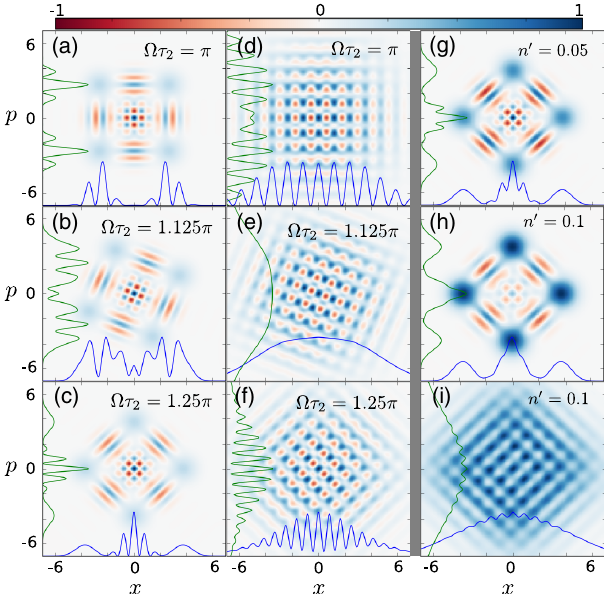
FIG. 5. Wigner distributions of the resonator ’ s state at different values of τ 2 . (a) – (c) Maximum interference from an initial pure state with unitary evolution. (d) – (f) Loss of interference due to initial thermal phonon occupation ¯ n ¼ 5 (with unitary evolution). (g) – (i) Loss of interference with nonunitary evolution equivalent to adding 0.05 (g) or 0.1 (h,i) thermal phonons. The initial state for panels (g) and (h) is the vacuum state, and the initial state of panel (i) is a thermal state with ¯ n ¼ 5 phonons. Blue and green traces show the position and momentum marginals, respectively, normalized to the same maximum. Each plot uses j α j ≈ 1 . 9 , and the color scale has been normalized to the range (cid:4) 1